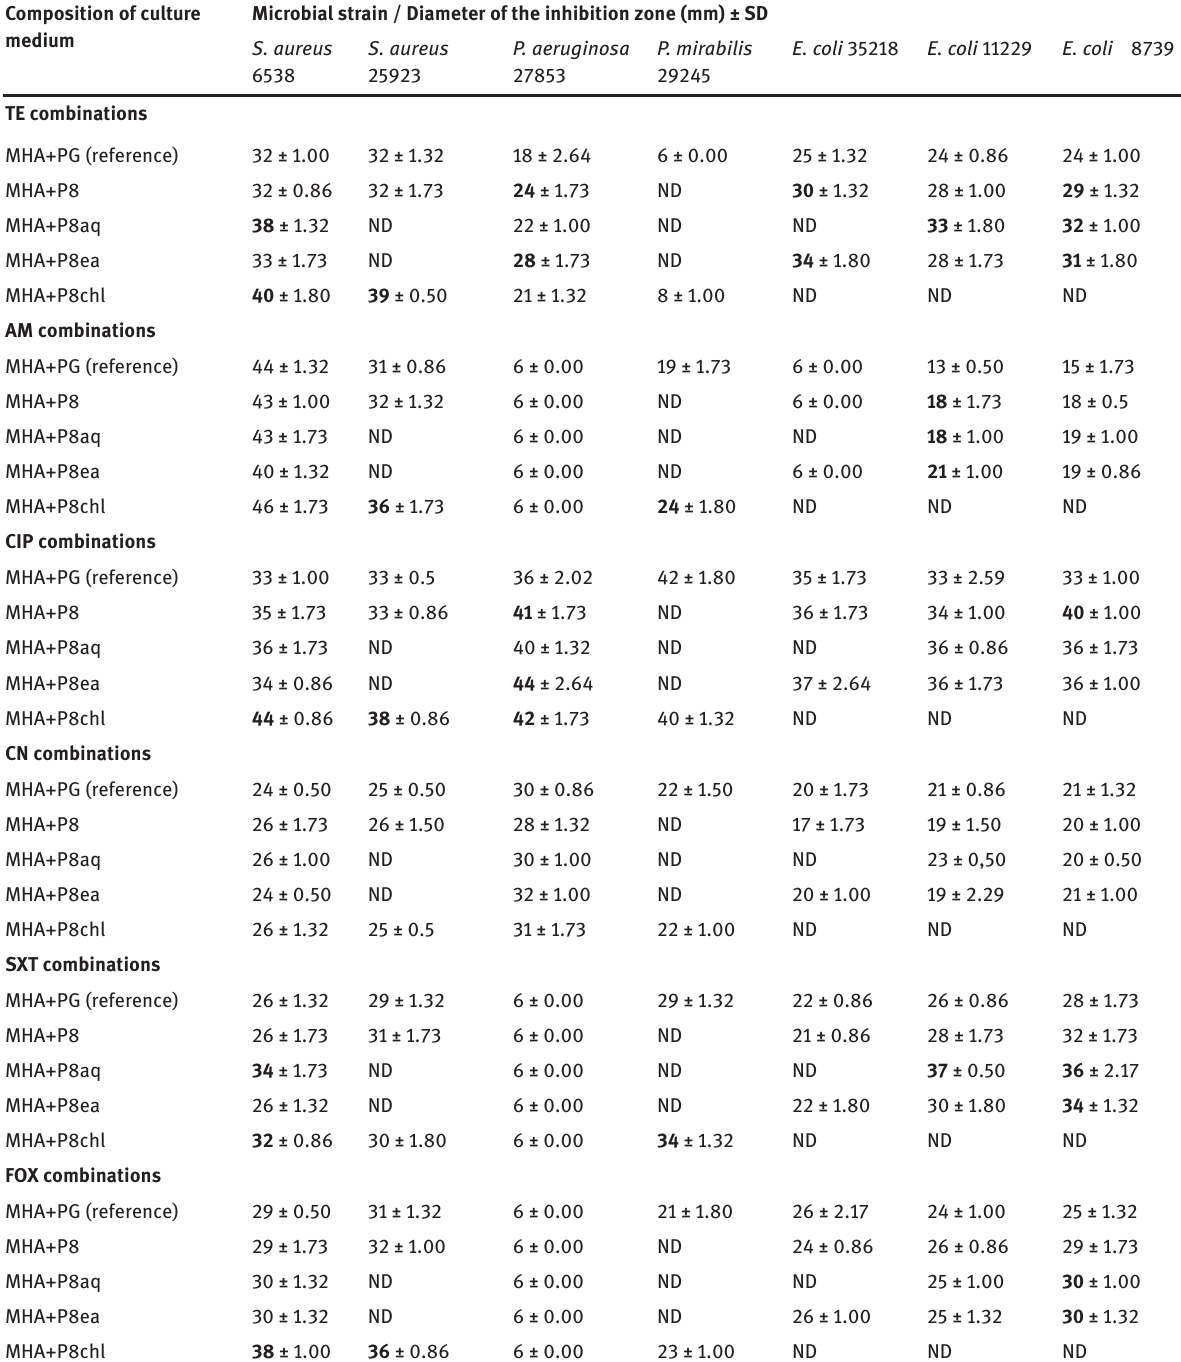
Table 3: Synergistic effects of Epilobi hirsuti herba extracts and antimicrobials on standard microbial strains. Composition of culture